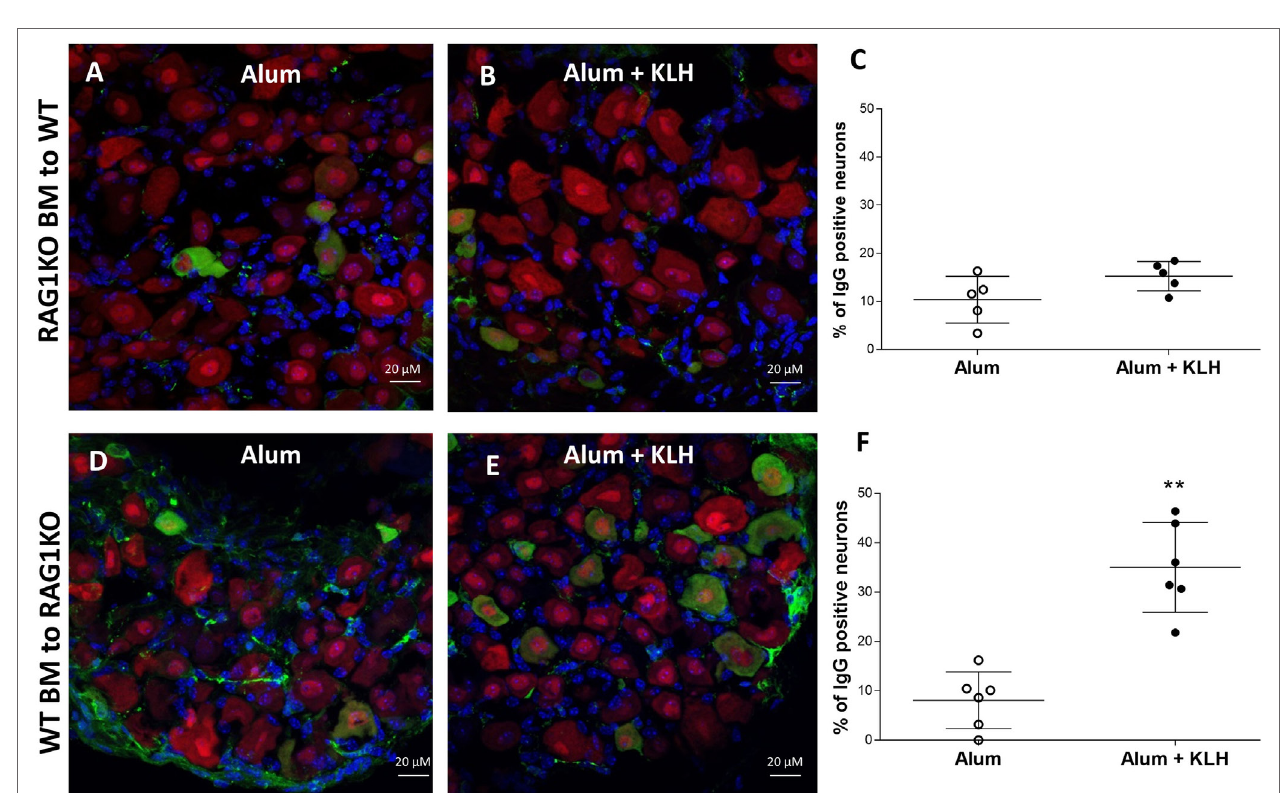
FigUre 7 | Dorsal root ganglion (DRG) neurons from chimeric mice with Rag1 knock out (KO) BM lack immunization-induced antibody accumulation. Immunostaining of whole DRGs isolated from alum-injected (a) and alum + KLH-immunized (B) chimeric mice ( Rag1 KO BM to WT) for neurons (NeuN, red), IgG (green), and nuclei (DAPI, blue). 400 × magnification; scale bar = 20 µm. (c) Percentage of double IgG-positive, NeuN-positive neurons (among total NeuN- positive neurons) in DRGs from isolated from alum-injected and alum + KLH-immunized chimeric mice ( Rag1 KO BM into WT mice); data are shown as mean percentage ± SD; ( n = 5 per group). Immunostaining of whole DRGs isolated from alum-injected (D) and alum + KLH-immunized (e) chimeric mice (WT BM into Rag1 KO) for neurons (NeuN, red), IgG (green), and nuclei (DAPI, blue). 400 × magnification; scale bar = 20 µm. (F) Percentage of double IgG-positive, NeuN- positive neurons (among total NeuN-positive neurons) in DRGs isolated from alum-injected and alum + KLH-immunized chimeric mice (WT BM to Rag1 KO); (mean percentage ± SD, n = 6 per group). ** P < 0.05 vs . alum-injected (Mann-Whitney